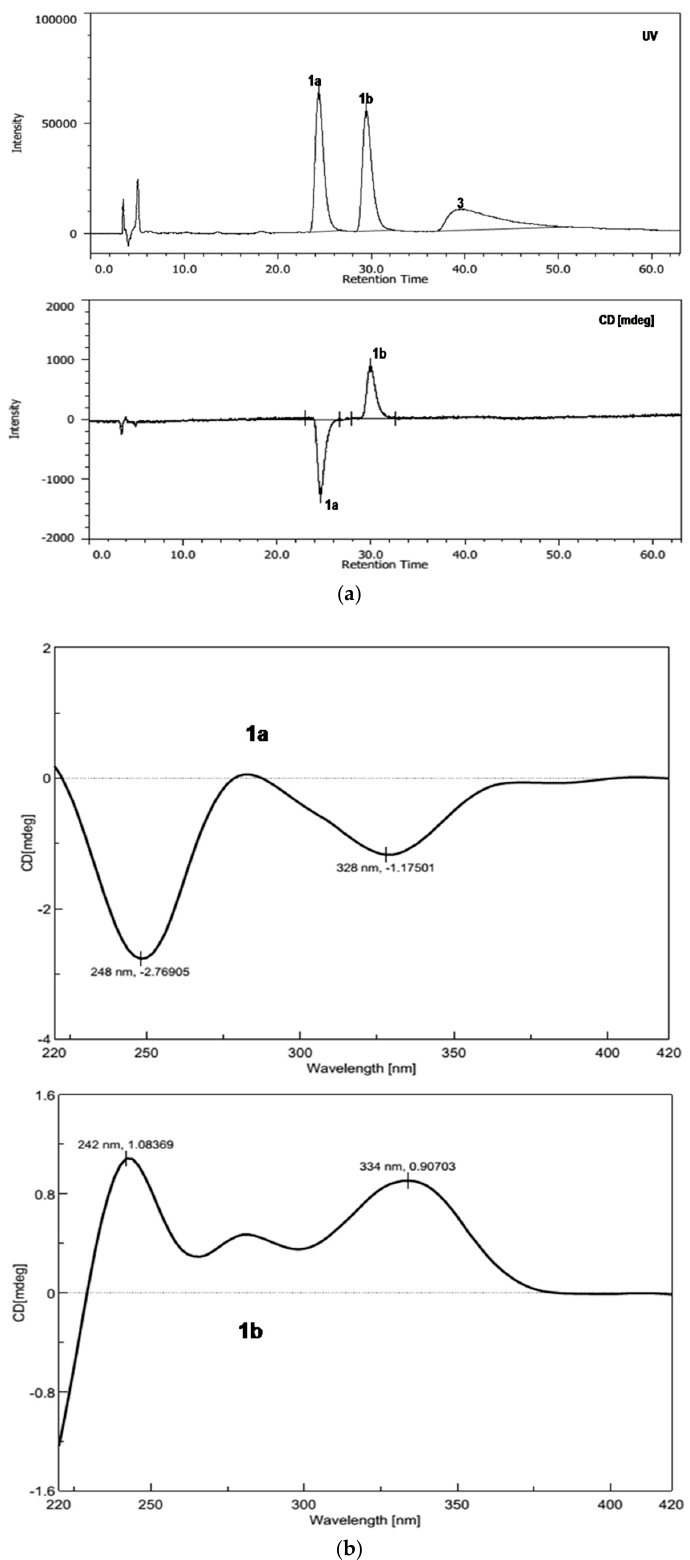
Figure 3. ( a ) HPLC-CD chromatogram of sporulosol ( 1 ) using a CHIRALPAK AD-H column (4.6 × 250 mm; 10% 2-Propanol in Hexane for 63 min; 1.0 mL/min); ( b ) HPLC-CD spectra of (1 ′ S )-sporulosol ( 1a ) and (1 ′ R )-sporulosol ( 1b ).